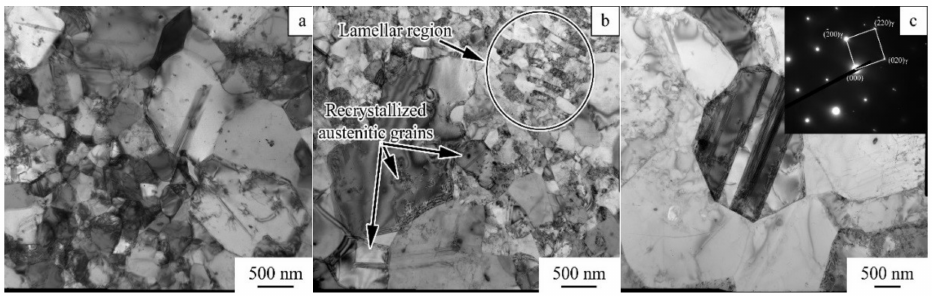
(cid:0) (cid:1) 111 reflection. γ